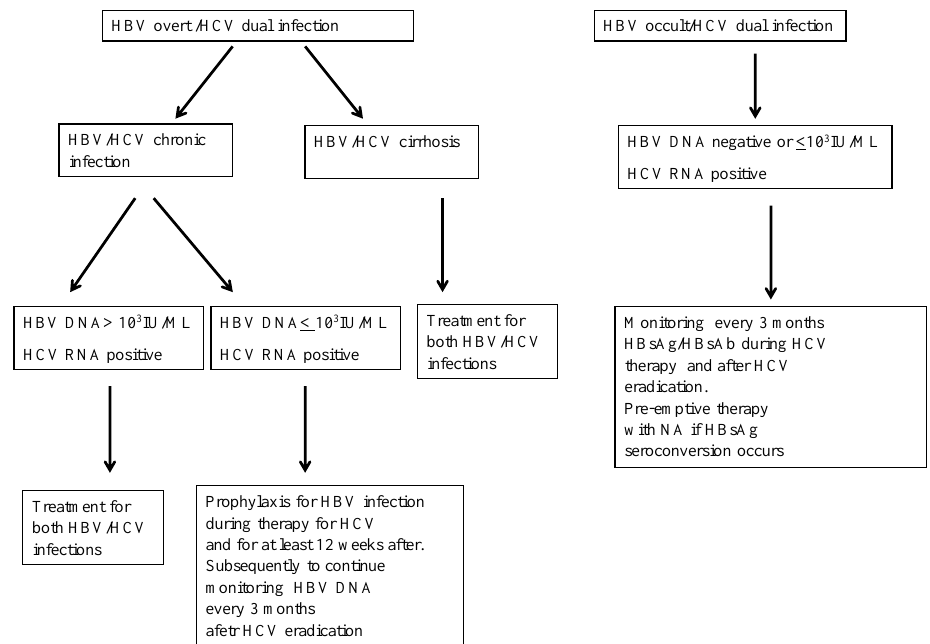
Figure 1. Management of HBV infection during and after DAA-based treatment. Footnotes: NA, nucleo(s)tide